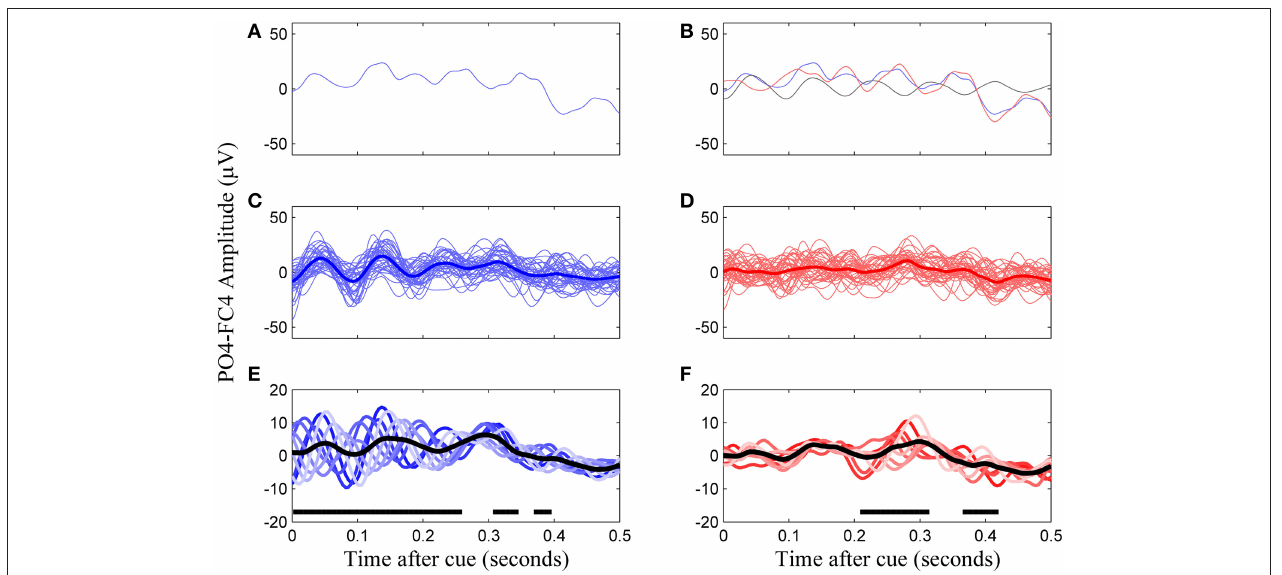
FIGURE 2 | Construction of the VEP template from phase-corrected left cue trials, channel PO4-F4, subject 8. (A) A single trial of VEP data. (B) Phase-matched correction by subtraction of a non-cued trial in the same phase group (falling within a same 45° window, black line) results in the phase-corrected trial (red line). (C) Uncorrected trials of the same phase group and their average. (D) Corrected trials of the same phase group and their average. (E) All eight phase groups and the average resulting VEP (black trace). Regions with thick horizontal lines indicate times during which the mean VEPs between the eight phase groups were significantly different as determined by ANOVA ( p < 0.05, Bonferroni corrected). (F) The final template for this subject is the average of the phase corrected trial groups (black line).